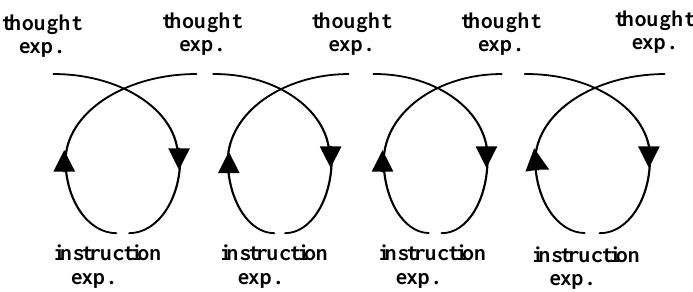
Figure 2. Developmental research, a cumulative cyclic process (Gravemeijer & Cobb,